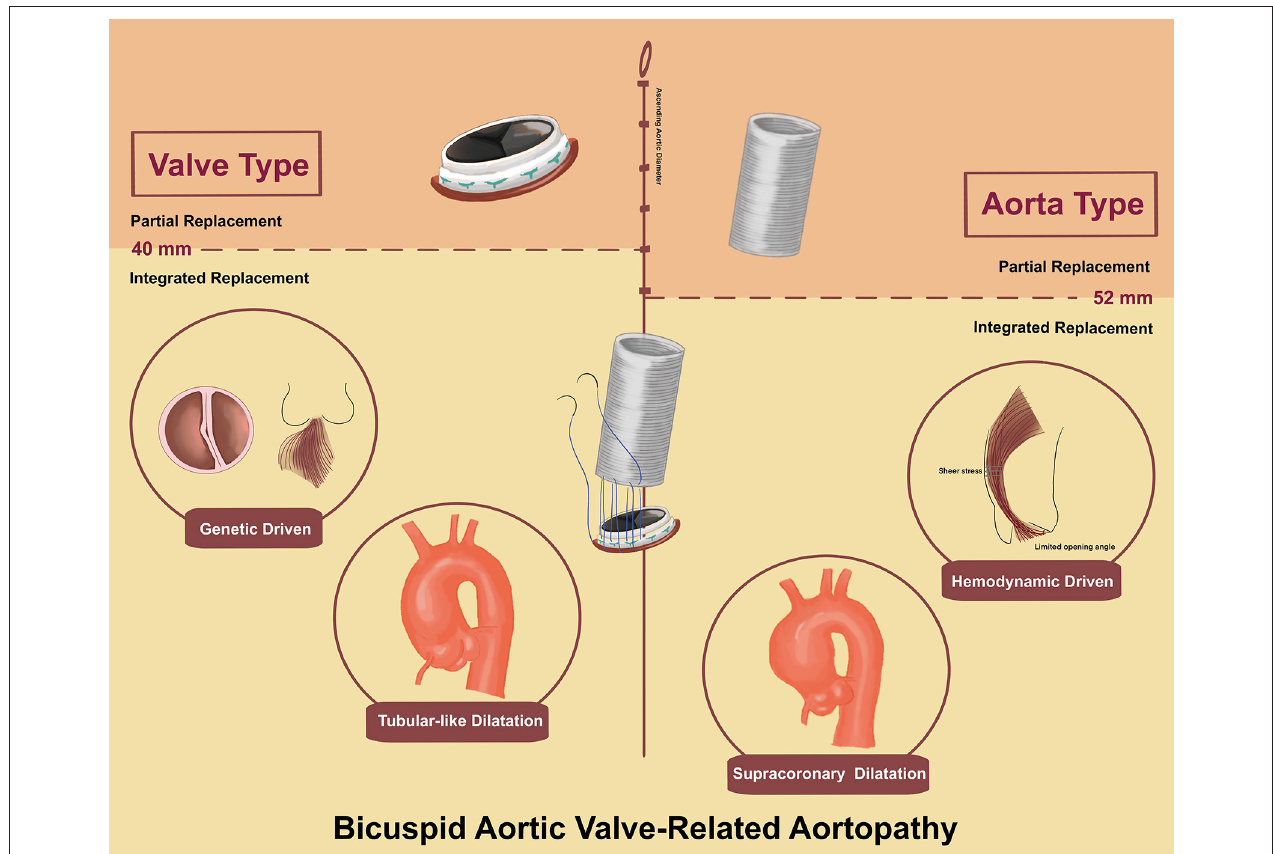
FIGURE 2 | BAV-related